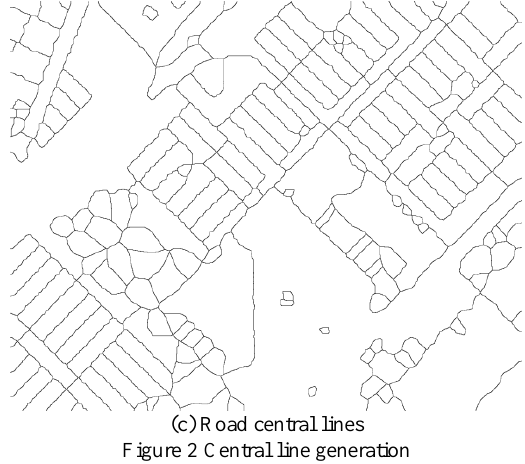
(c) Road central lines Figure 2 Central line